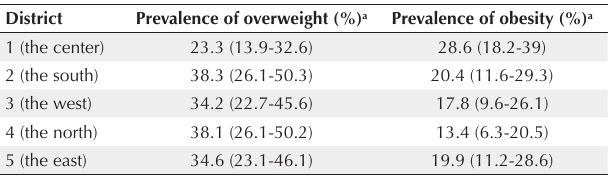
Table 3. Prevalence of Overweight and Obesity Among Women 15 Years Old or Older in Different Districts After the Urban HEART Intervention District Prevalence of overweight (%) a Prevalence of obesity (%) a